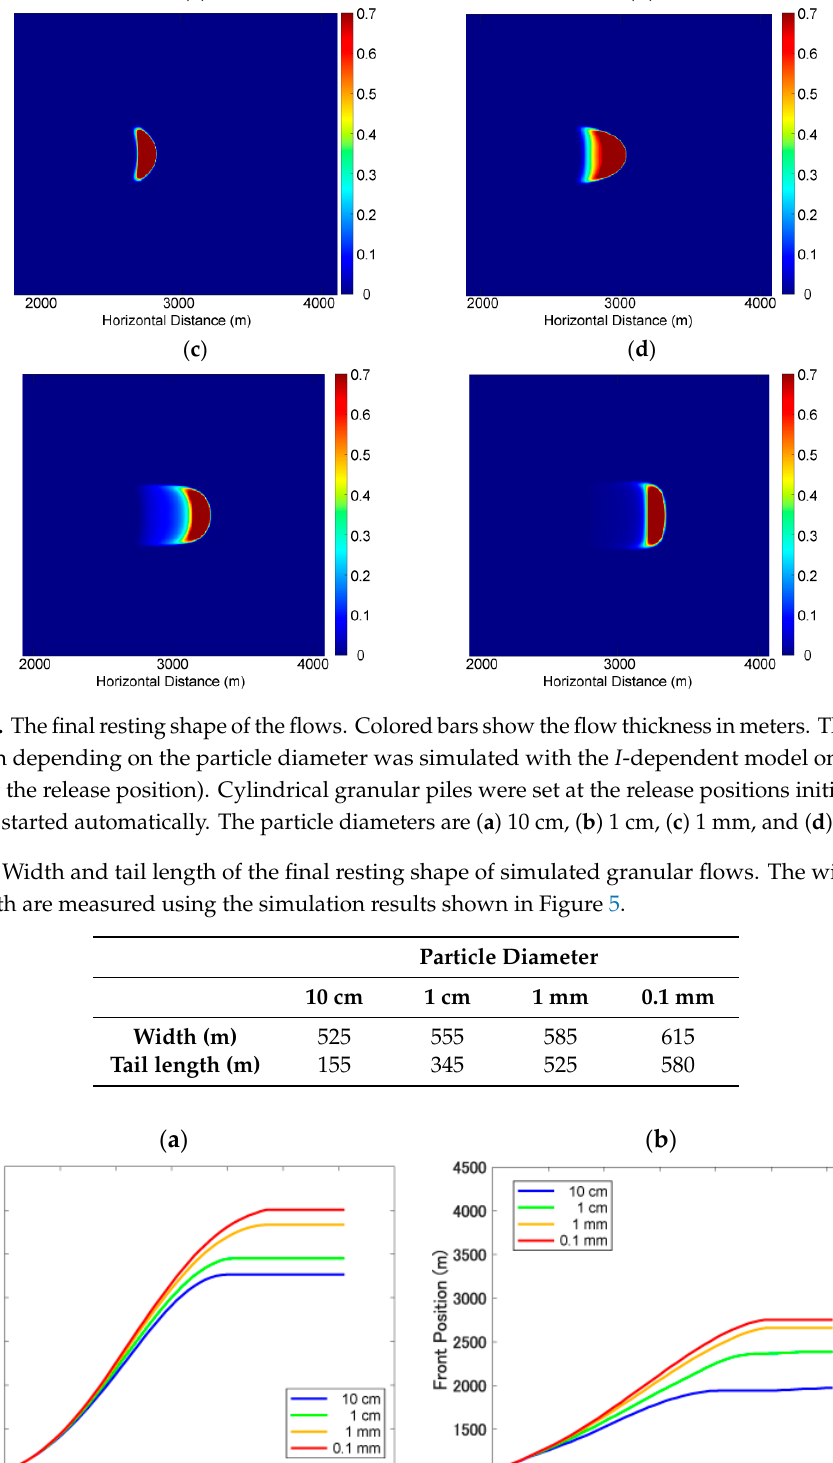
Figure 6. A numerically simulated variation of the flow front positions over time. Simulations were implemented for a flow on the ( a ) 47° slope (at the release position) and ( b ) 26° slope (at the release position).